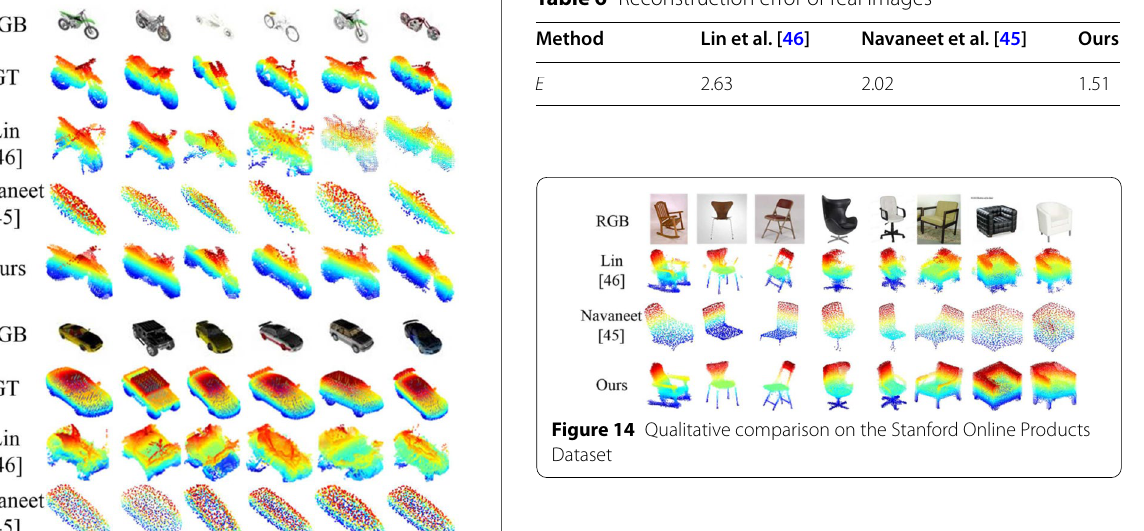
Table 6 Reconstruction error of real images